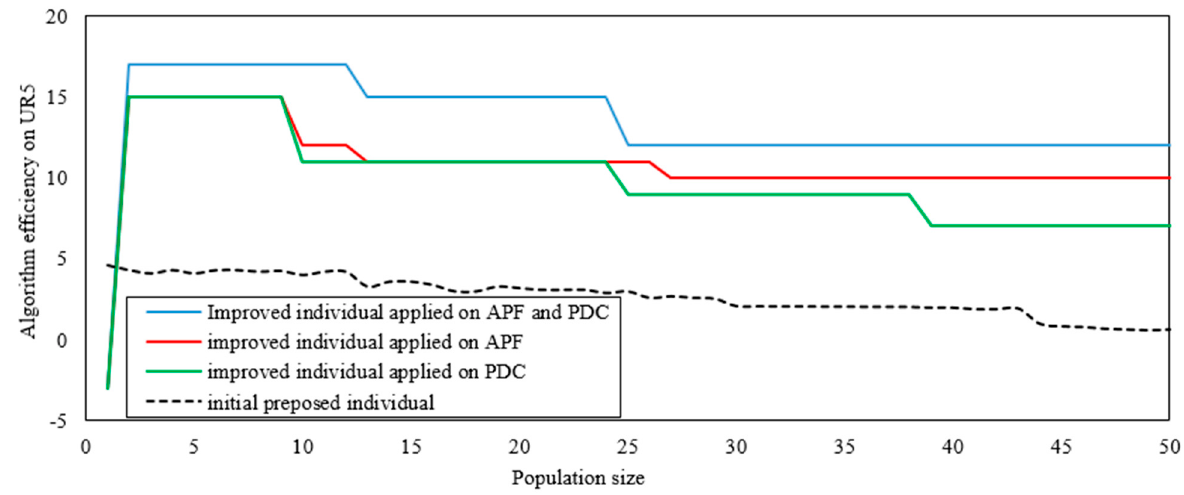
Figure 11. DE effecting with 30 individuals and 50 generations.